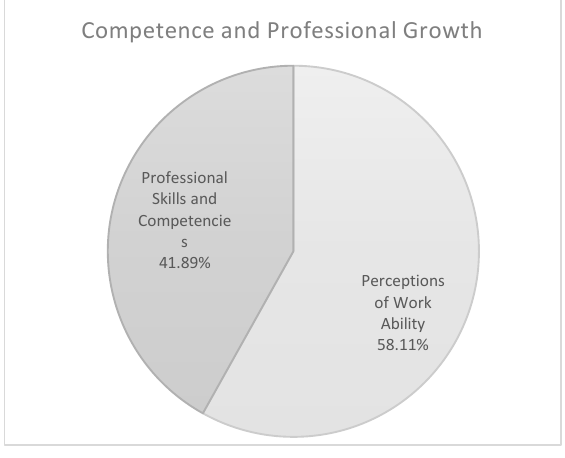
Figure 7. Theme n. 4.